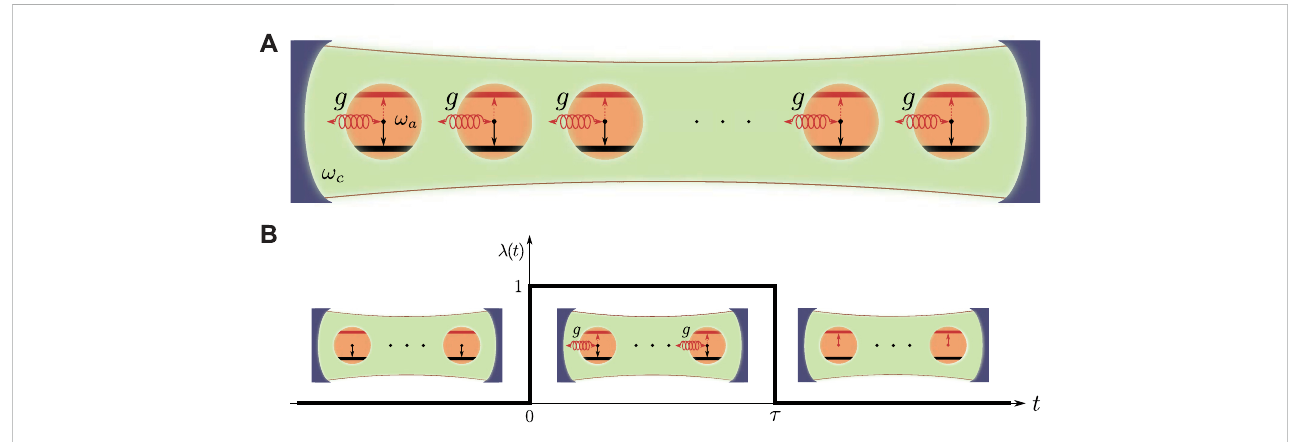
FIGURE 1 (A) Schematic representation of a Dicke quantum battery as an array of identical two level systems with energy splitting Z ω a . The ground state (black bar) and excited state (redbar)are equivalentto thestates of spin down and up (see arrows).The batteries are charged inside asingle cavity (green background) of photonic mode ω c and g isthecoupling constant amongTLSs andcavity photons. (B) Initially thecouplingsignal λ issettobe0and thebatteriesareprepared in the ground state. The coupling is switched on at time t =0 + and maintained as constant g for a period of τ . Then we turn off the coupling and the charging process therefore stops. Energyistransferredfromcavity photons into thebatteries whose fi nal statesareexpectedto befully charged(all